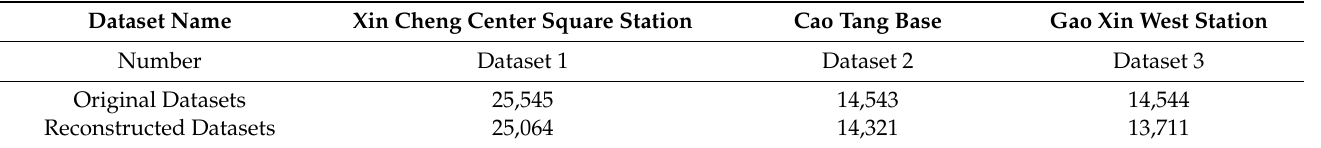
Table 6. The quantity of data in three datasets.